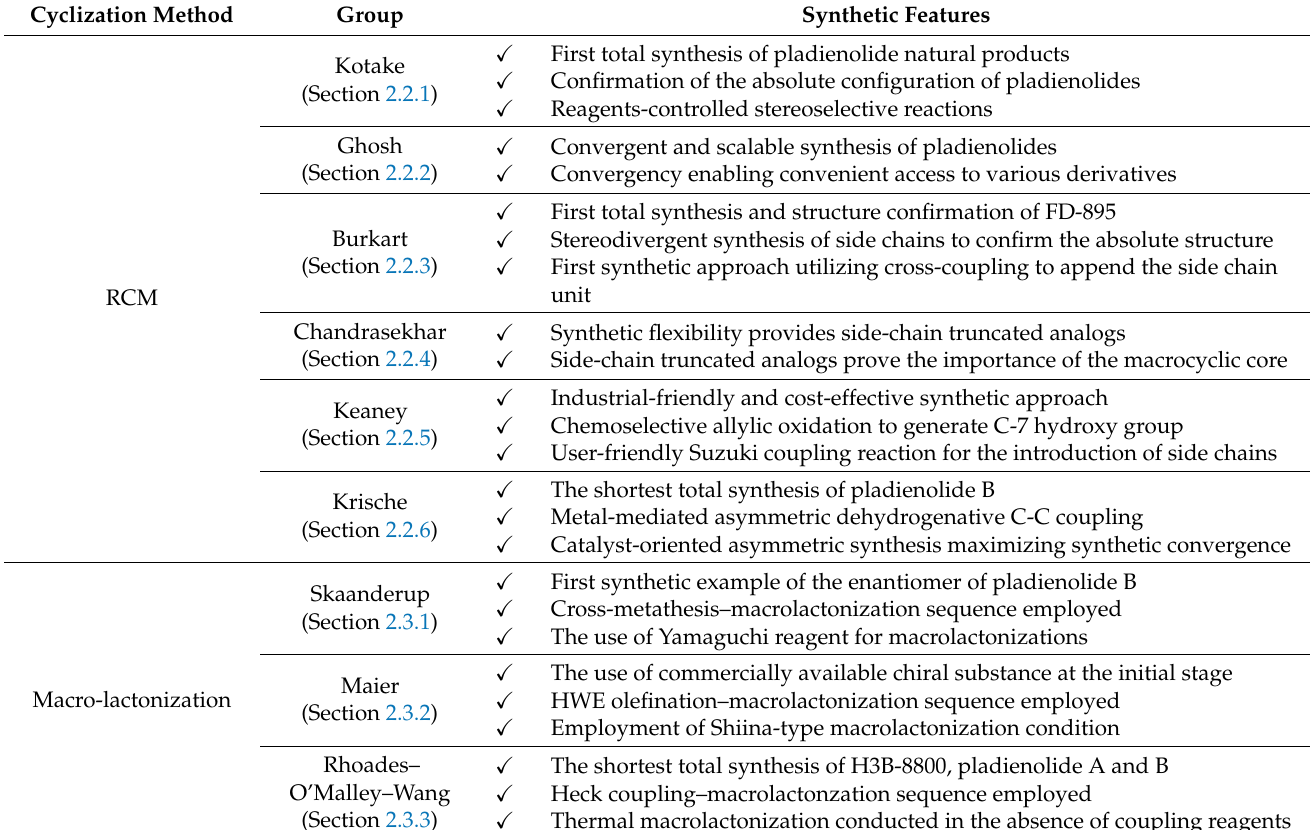
Table 2. Synthetic features of the total syntheses covered in this